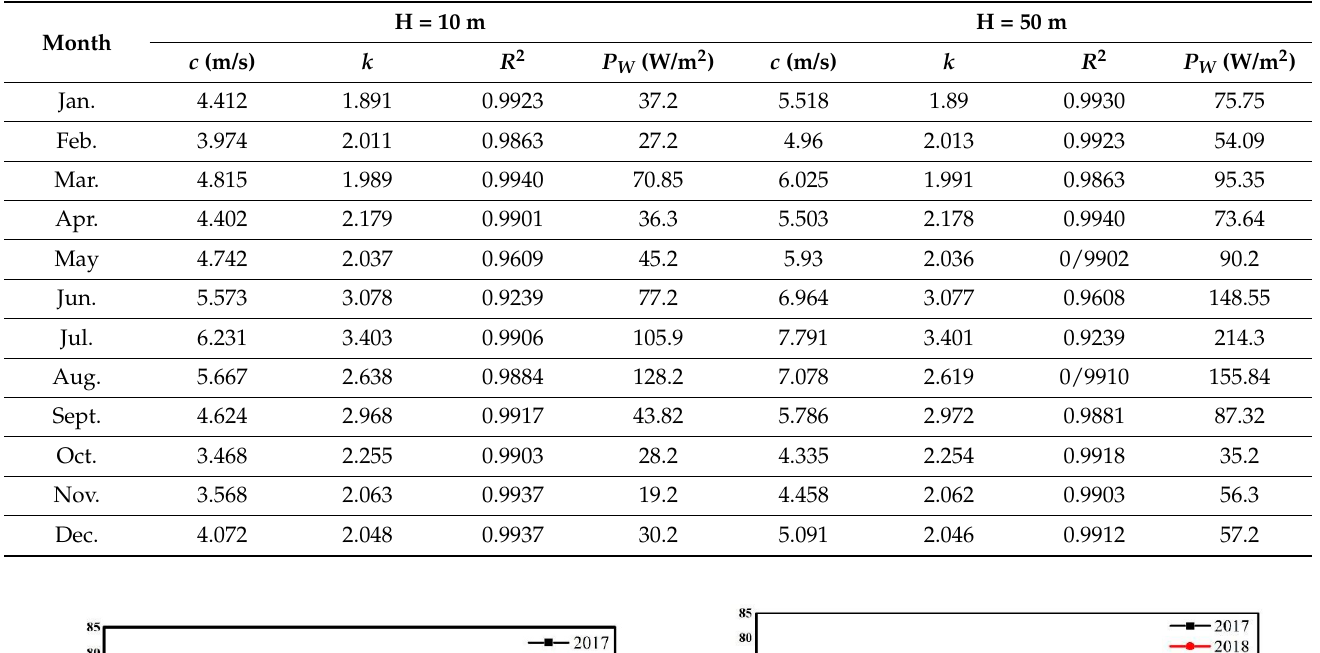
Table 11. The Weibull parameters by Mabchour’s Method (MMab) for RAWA city at 10 m and 50 m height, 2019.